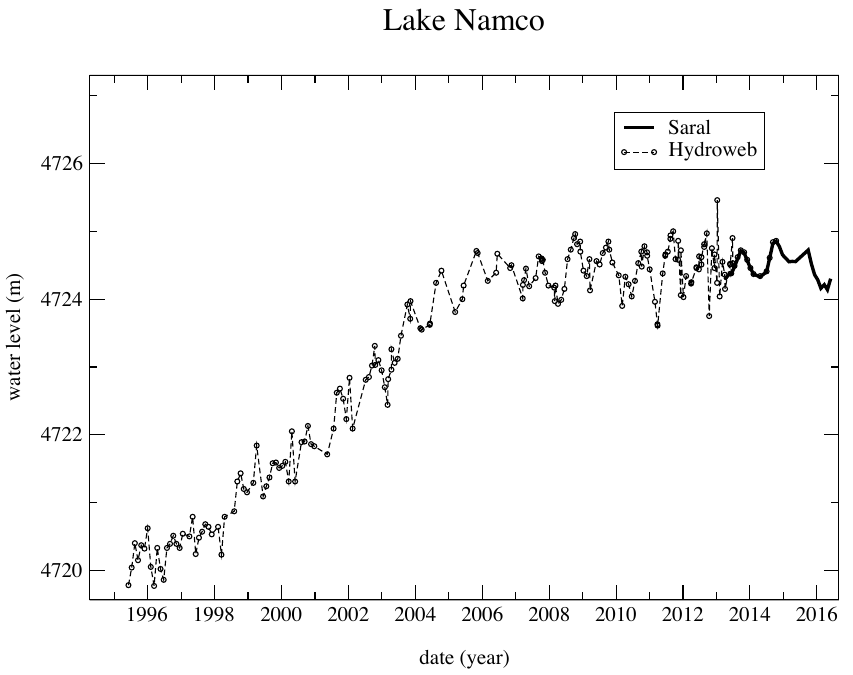
Figure 20. Water level change of the Namco lake from a multi-satellite data processing. After a long period of increasing, the lake level has stabilized in 2006/2007 (extracted from Hydroweb database http://hydroweb.theia-land.fr/ and from SARAL/AltiKa data processing for the period